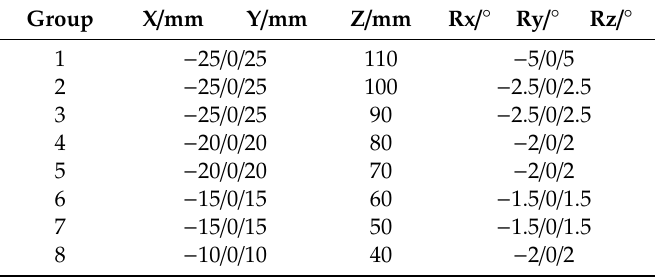
Table 3. The relative poses between the two docking